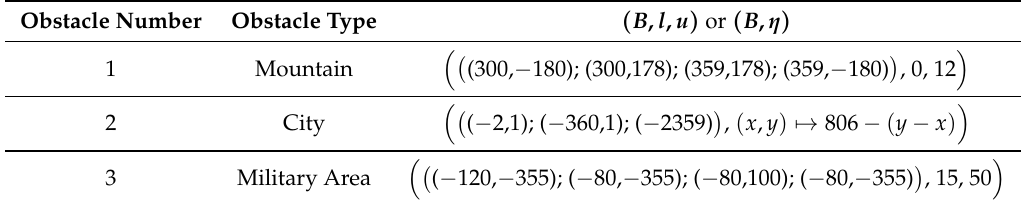
Table 2. The obstacles and city for test 2 (see Figure